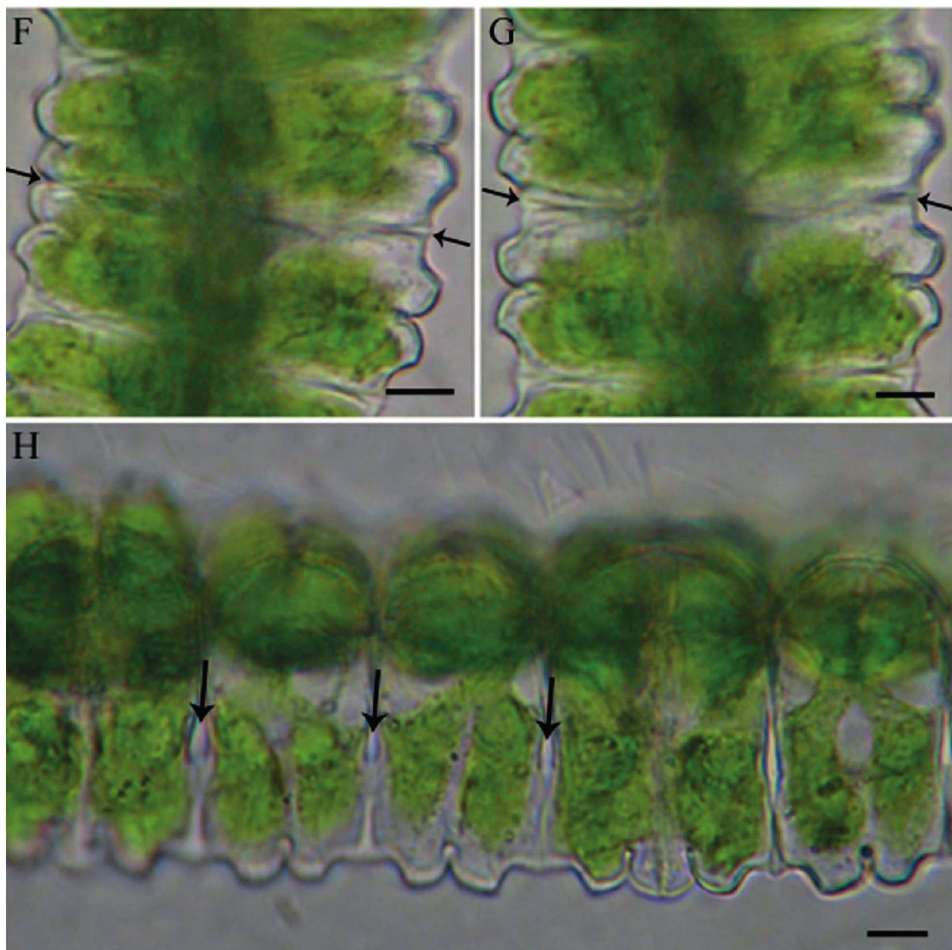
Figure 1. Details of cell development of Desmidium in light and electron microscopy. Light microscopic images show the same stages of development as electron micrographs aside. ( A ) Part of a Desmidium filament with an adult (ac) and a dividing cell (dc). The cell shape is established by a newly-formed primary wall in the isthmus (asterisks); ( B ) Two adult cells (cross section) connected by primary wall remnants (arrowheads). Isthmus marked by asterisk; ( C ) Newly-formed primary wall emanating from the isthmus (asterisks) and young septum; ( D ) Polar view of wall cylinder (arrows) in two developing cells and connecting cell wall (arrowheads); ( E ) Ultrastructure of dividing Desmidium cells (cross section). The newly- formed primary wall arising from the isthmus (asterisks), and outer and inner cell wall cylinders (arrows) perpendicular to the septum are visible. Remaining cell wall connection between two cells indicated by arrowheads; ( F ) Splitting of the connecting cell wall visible at the cell edges. On the left side the wall has split only slightly, on the right side more distinctly (arrows); ( G ) also, the left side has split completely. The arrows now point at the remaining connecting wall; ( H ) The cell wall within the inner wall cylinder has split as well, recognizable by the appearing background (arrows). N: Nucleus; P: Pores; PW: Primary wall; S: Starch grains; SE: Septum; SW: Secondary wall. Bar = 5